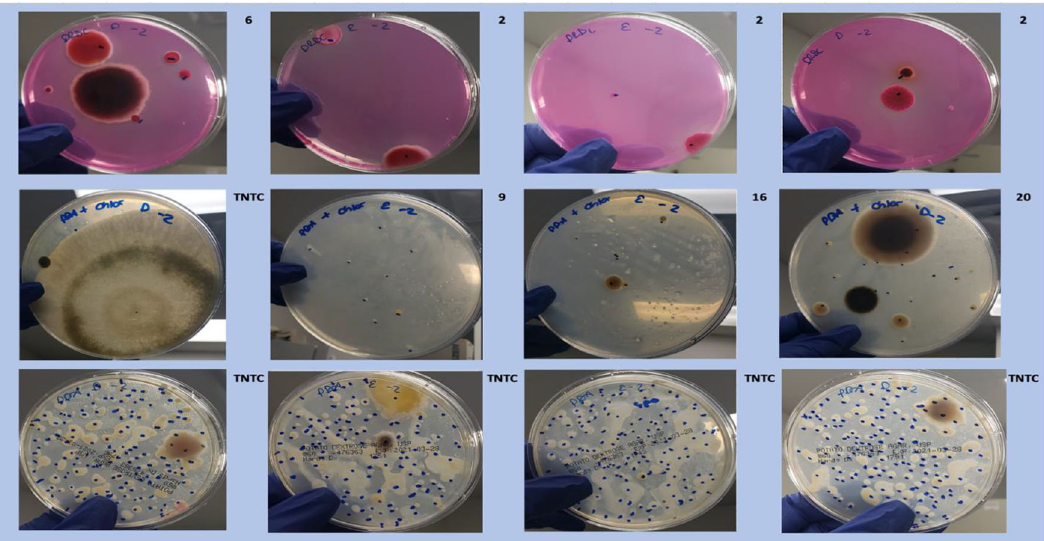
Figure 4. Plating images. Dichloran Rose Bengal (Top). Potato Dextrose Agar with chloramphenicol (PDA – CAMP, Middle). PDA without CAMP (Bottom).